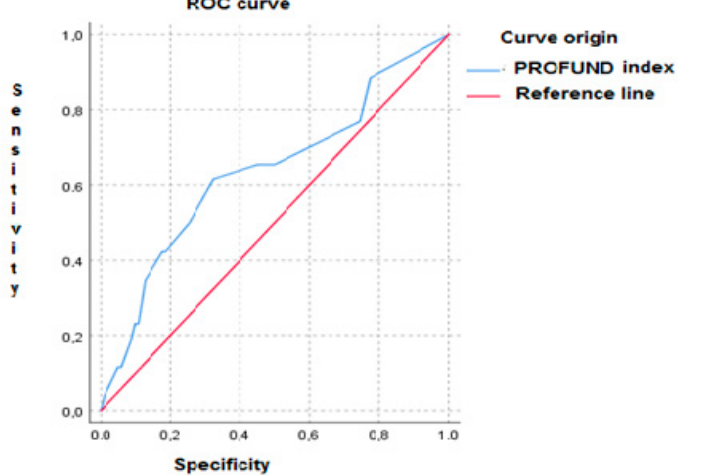
Figure 1. ROC curve of the PROFUND index for in-hospital mortality and 30-day follow-up in patients with AHF.